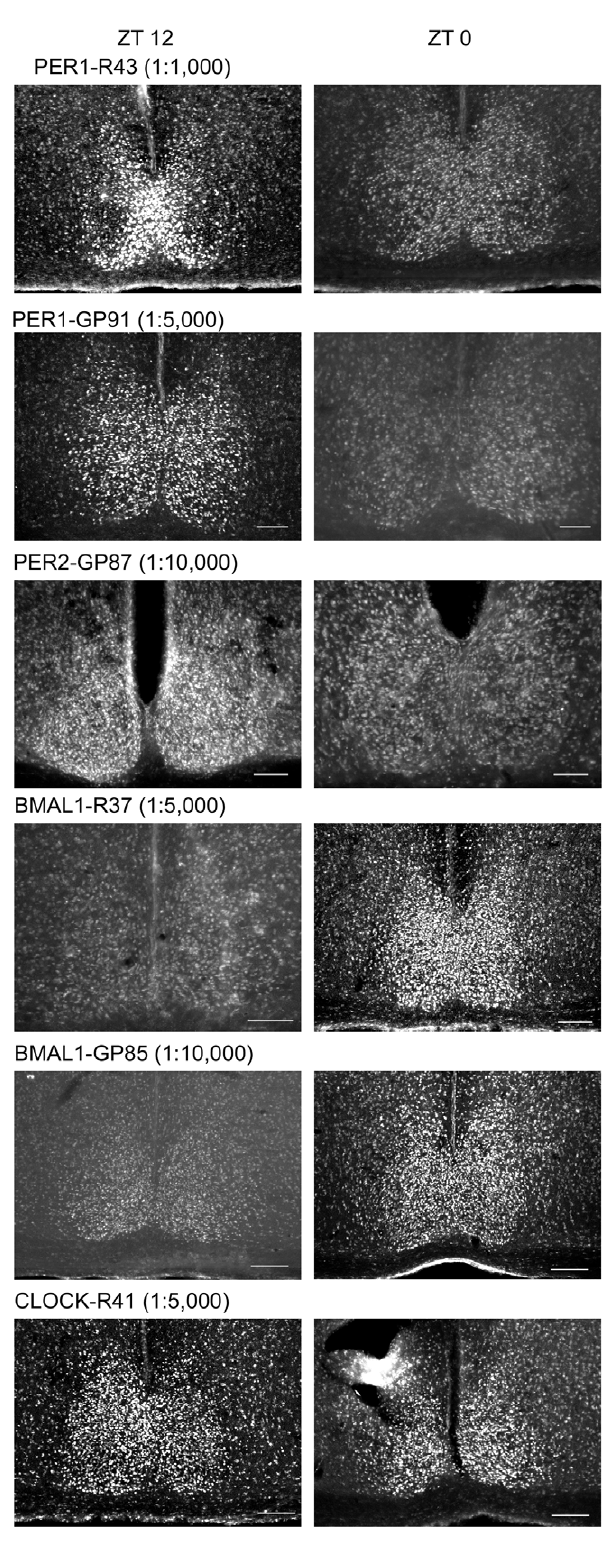
Figure 3. Photomicrographs of hamster SCN sections immu- nostained with PER1, PER2, BMAL1 and CLOCK antibodies. Columns show the staining at ZT12 (left) and ZT0 (right) level for each antigen. The antigen, host number (R=rabbit; GP=guinea pig) and antibody concentration used for each antibody is indicated. Scale bar, 100 m